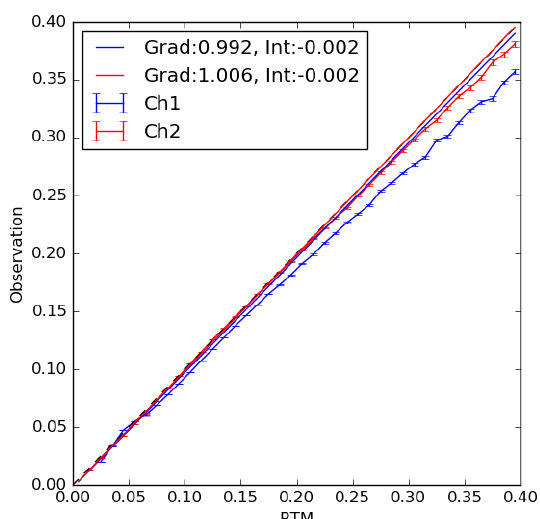
Figure 3. Observed reflectance as a function of the corrected RTTOV v11.3 radiative transfer model (RTM) reflectance for Channel 1, 0.6 µ m (blue) and Channel 2, 0.8 µ m (red). The linear correction used is that defined in Figure 1. Joined data points show data binned at 0.01 in the RTM reflectance with associated error bars. Solid lines show a linear regression of the observed reflectance against the RTM in each channel. Dashed black line shows the 1:1 relationship. Legend shows the gradient (Grad) and intercept (Int) of the linear fits to the